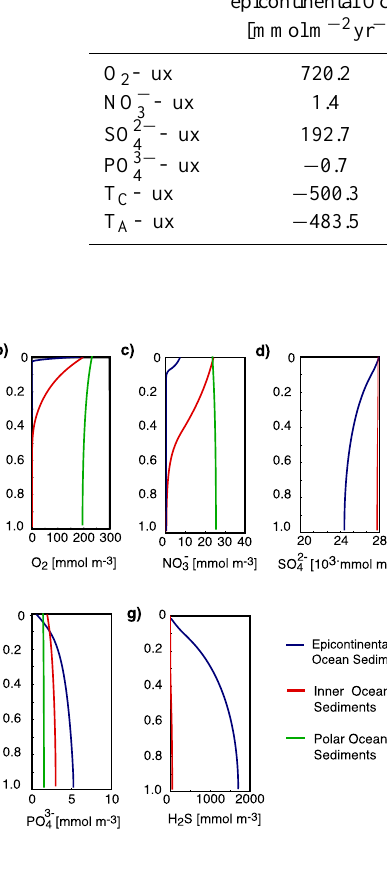
Fig. 6. Simulated steady state depth-profiles of (a) particulate or- Figure 6: Simulated steady state depth-profiles of a) particulate organic carbon, b) oxygen, c) ganic carbon, (b) oxygen, (c) nitrate and (d) sulfate, as well as of nitrate and d) sulfate, as well as of e) ammonium, f) phosphate and g) sulfide in epicontinental, (e) ammonium, (f) phosphate and (g) sulfide in epicontinental, inner inner and polar ocean sediments. and polar ocean